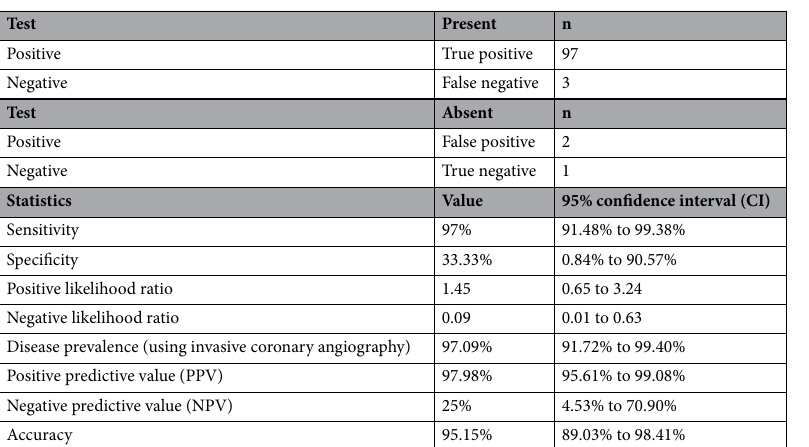
Figure 4. LV volumes and systolic function (mean ± SD) in IHD male and female patients using CMRI.